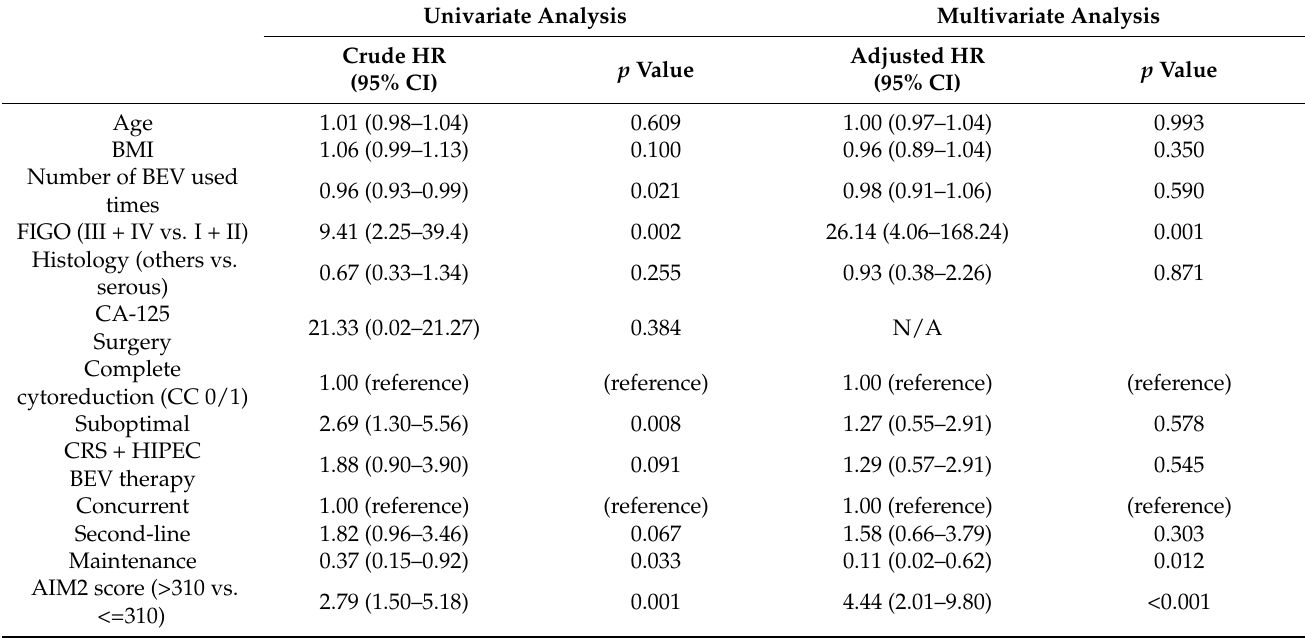
Table 3. Univariate and multivariate analyses of demographic and clinical factors associated with recurrence. Univariate Analysis Multivariate